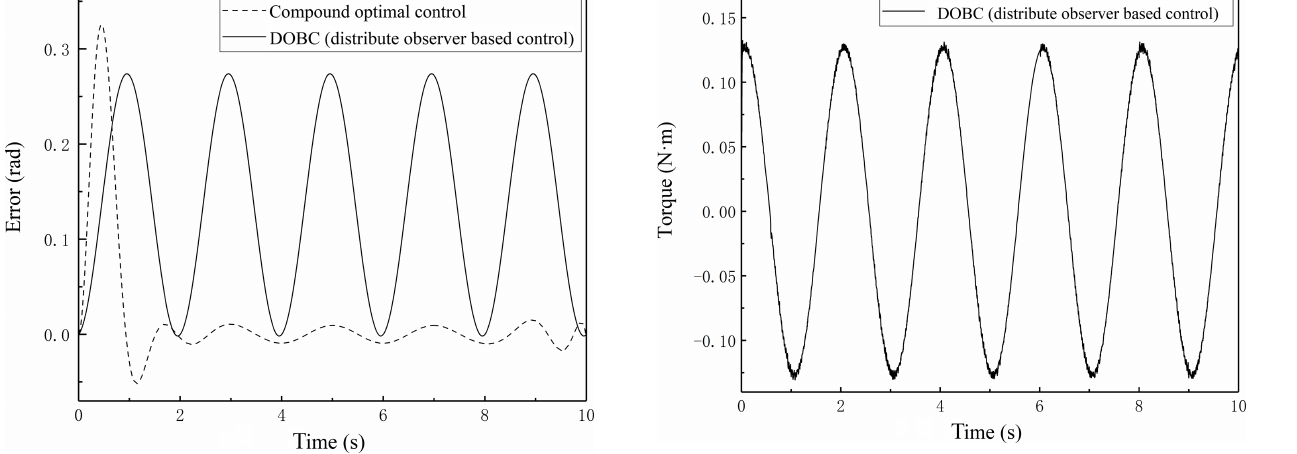
Figure 6. Tracking error of DOBC and the compound optimal con- trol.